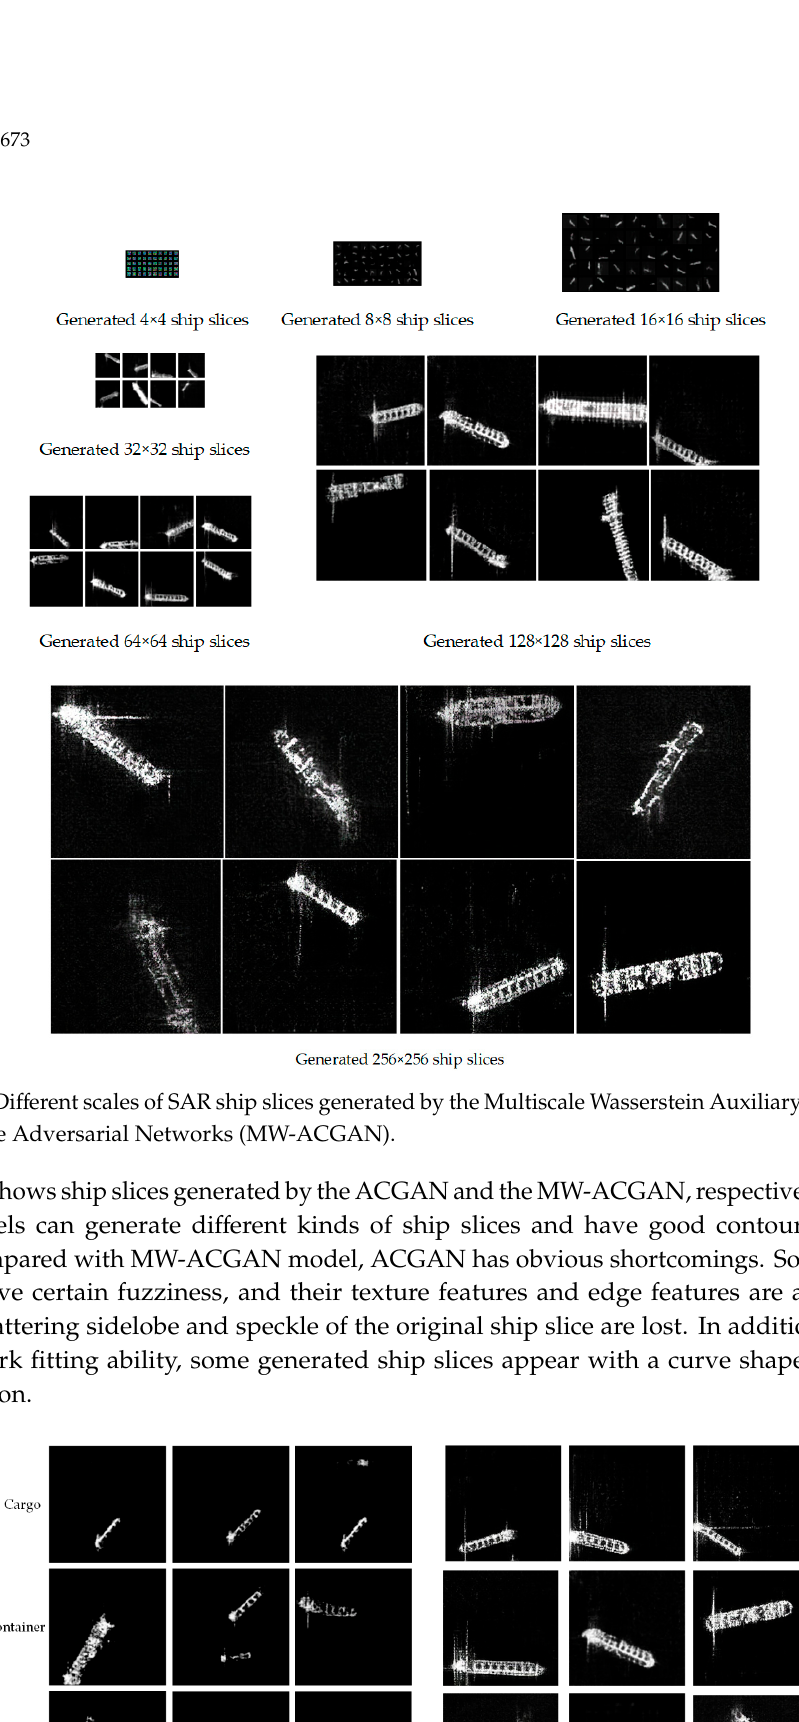
Table 2. ResNet18 training set and test set. Ship Types